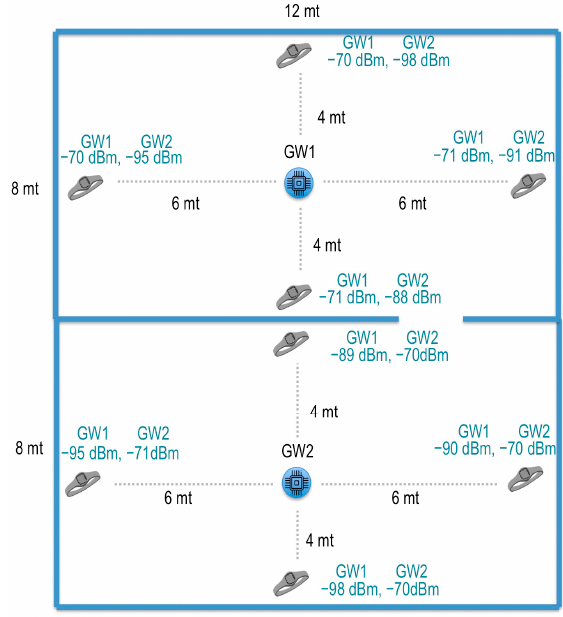
Figure 14. RSSI tests on BLE with two gateways.